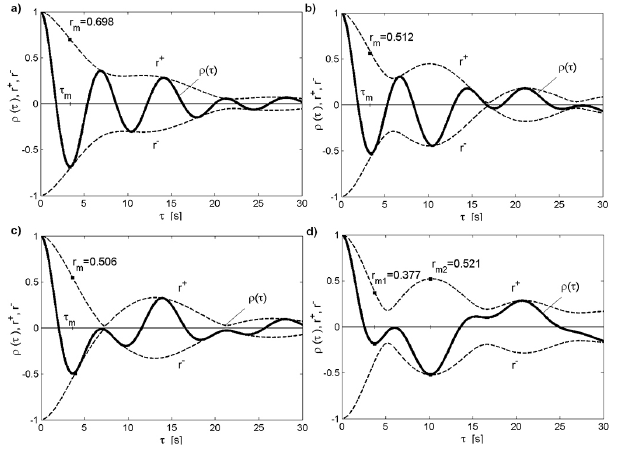
Figure 3. Autocorrelation functions associated with the wave spec- tra in Fig. 2: (a) 8228, (b) 8229, (c) 8230 and (d) 8231.